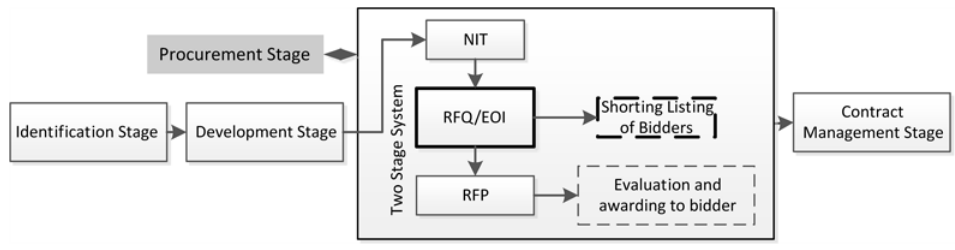
Typical Procurement Process for PPPs in